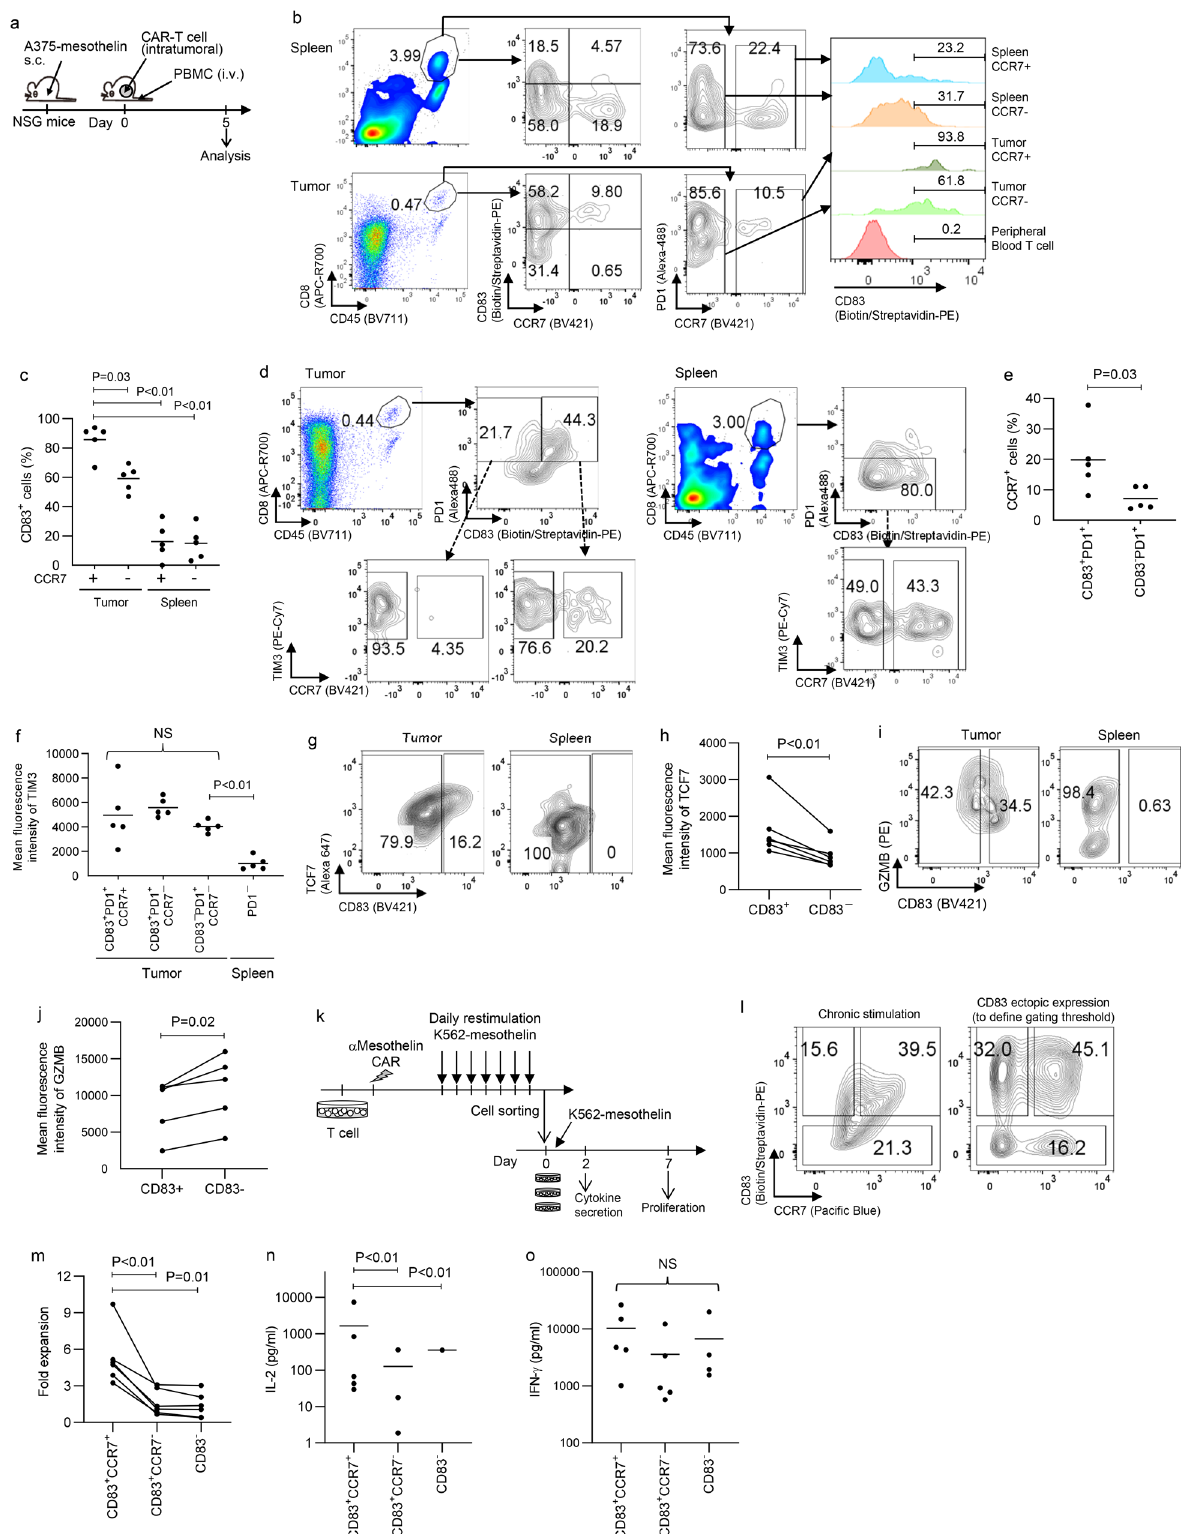
mouse CD8 + T cells in fi ltrating B16 melanoma tumor tissue 27 . Among the six clusters identi fi ed by unsupervised analysis (Fig. 6e), clusters 2 and 4 included T cells that expressed memory- related genes ( Ccr7 , Tcf7 , Sell , and Il7r ), whereas exhaustion- related genes ( Pdcd1 , Lag3 , Havcr2 , Tox , and Nr4a1 ) were